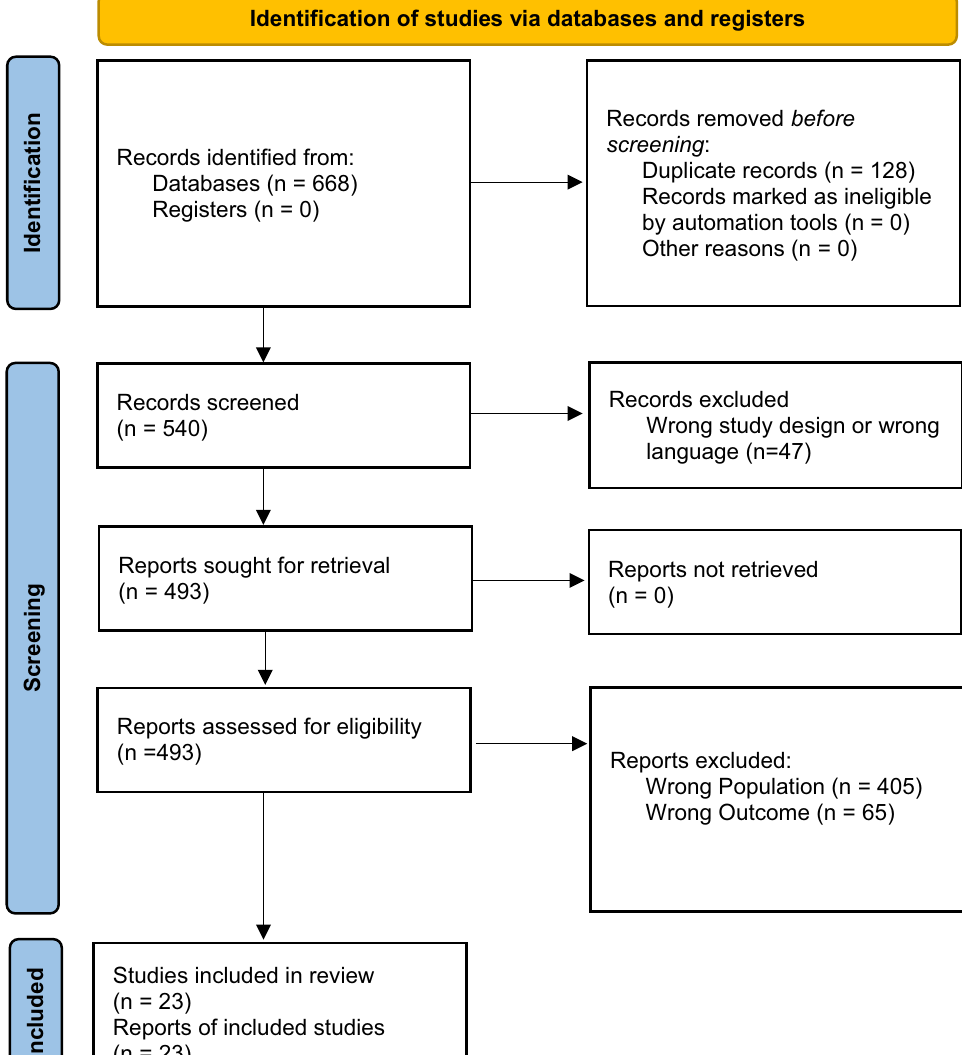
Fig. 1 Flow diagram of identified and analysed